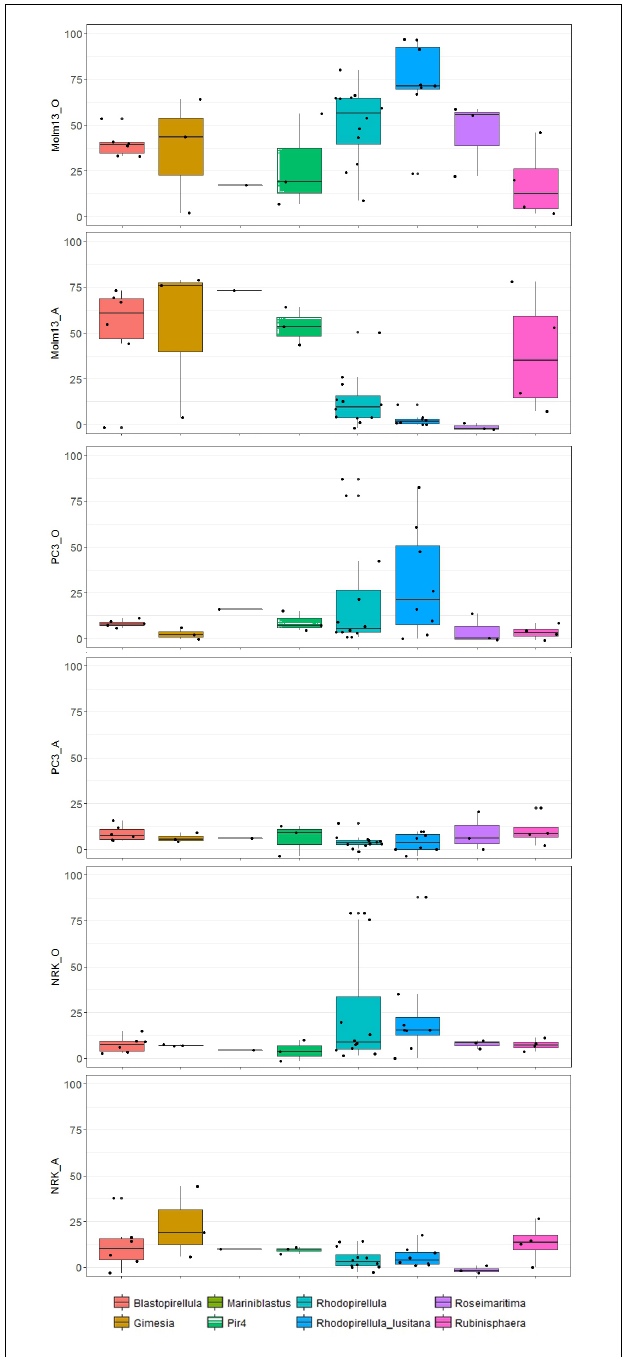
FIGURE 2 | Boxplots indicate the effects in % cell death on cancer cell lines (PC3 and MOLM-13) and controls (NRK) in aqueous (A) and organic phase (O) of strains affiliating with different subgroups of Planctomycetes . The band inside each box represents the median and the black points indicate values for individual